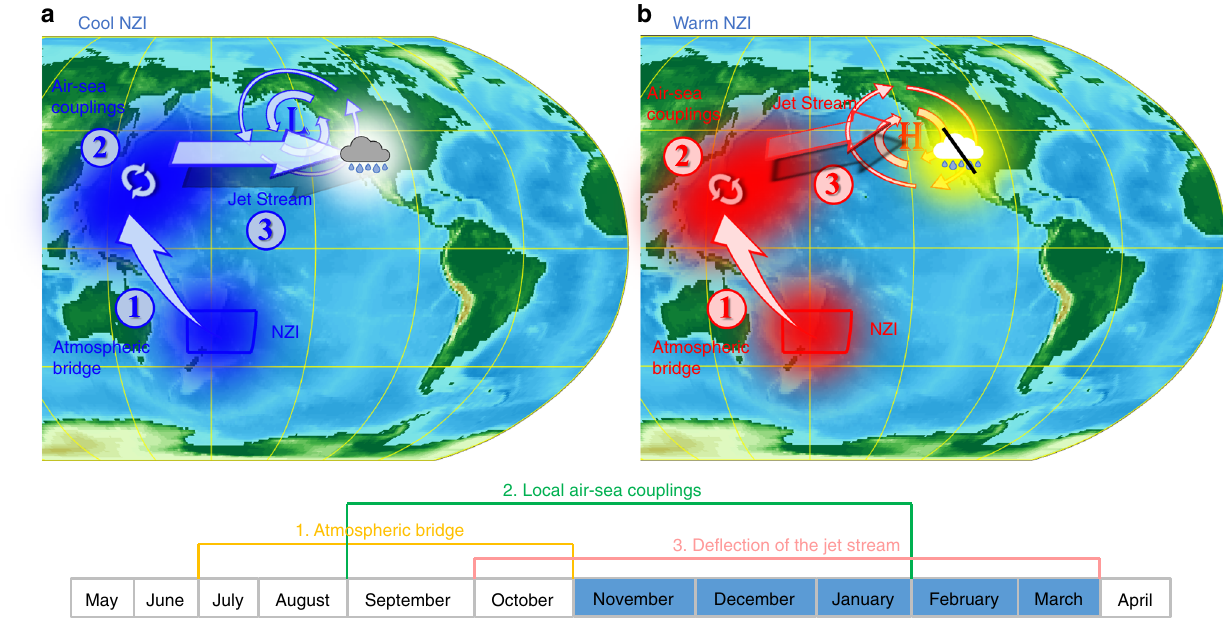
Fig. 5 The New Zealand Index (NZI) teleconnection depends on a western Paci fi c ocean – atmosphere pathway. a Negative SST anomalies (blue shading) in the NZI region cascade in the northern hemisphere through a late summer interhemispheric atmospheric bridge and are maintained by air-sea coupling until the following winter. The SST anomalies affect the atmospheric pressure in the US west coast and strengthen the regional jet stream which brings more winter storms in the SWUS; b Late-summer positive SST anomalies (red shading) in the NZI region de fl ect the jet stream to the north, leading to dry conditions over the